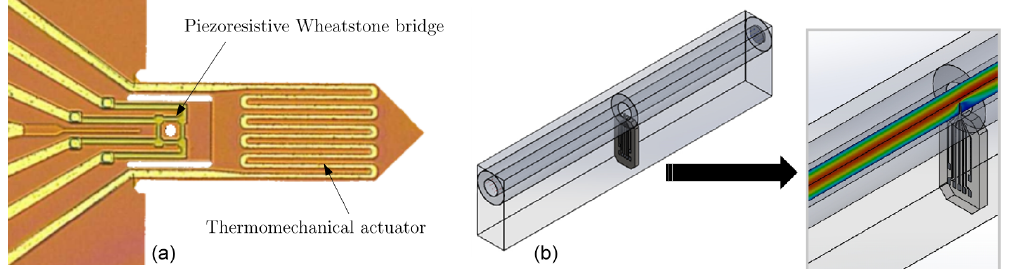
Figure 1. Magnification of a cantilever sensor with a piezoresistive resistance bridge and a meander-shaped thermomechanical actuator (Rangelow et al., 2005) (a) and model of the measurement chamber with a flow channel of 1mm diameter and cantilever sensors positioned vertically in the flow channel, in which the gas flow is illustrated (b)